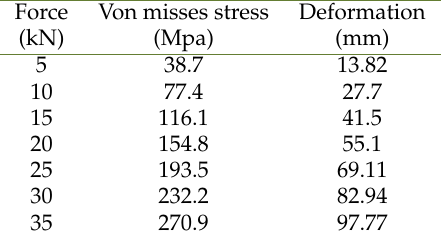
Table 1. specimen FEA result.